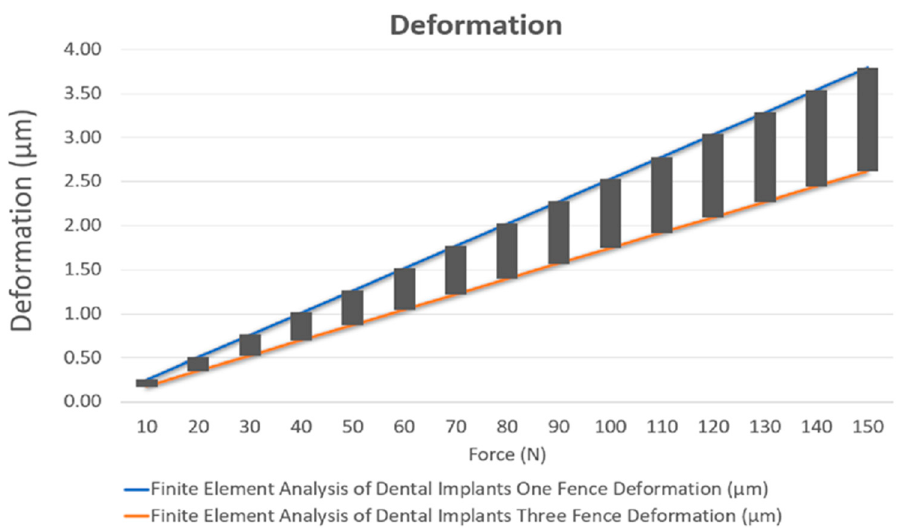
Figure 5. Stress analysis of the two designs at various loads.